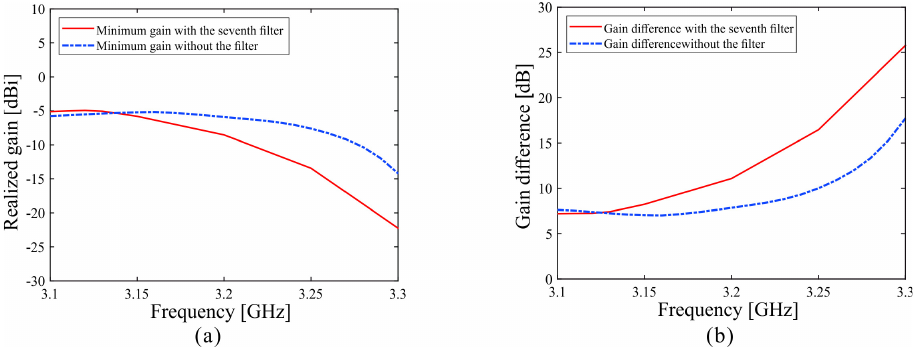
Figure 7. Comparative analysis with and without filter: ( a ) simulated minimum gain and ( b ) simulated gain